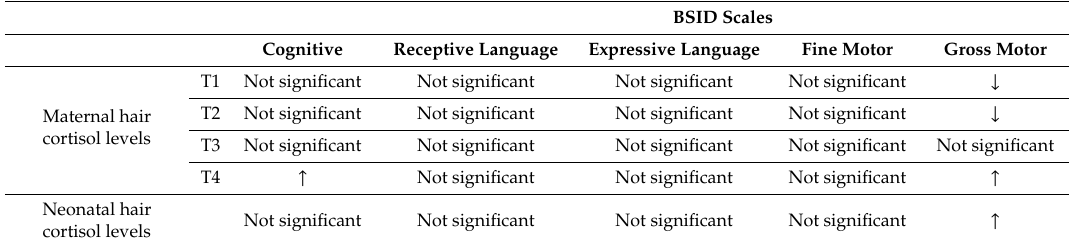
Table 5. Summary of the hierarchical regression models using maternal and neonatal hair cortisol levels as predictors of infant neurodevelopment at six months of age. BSID Scales Cognitive Receptive Language Expressive Language Fine Motor Maternal hair cortisol